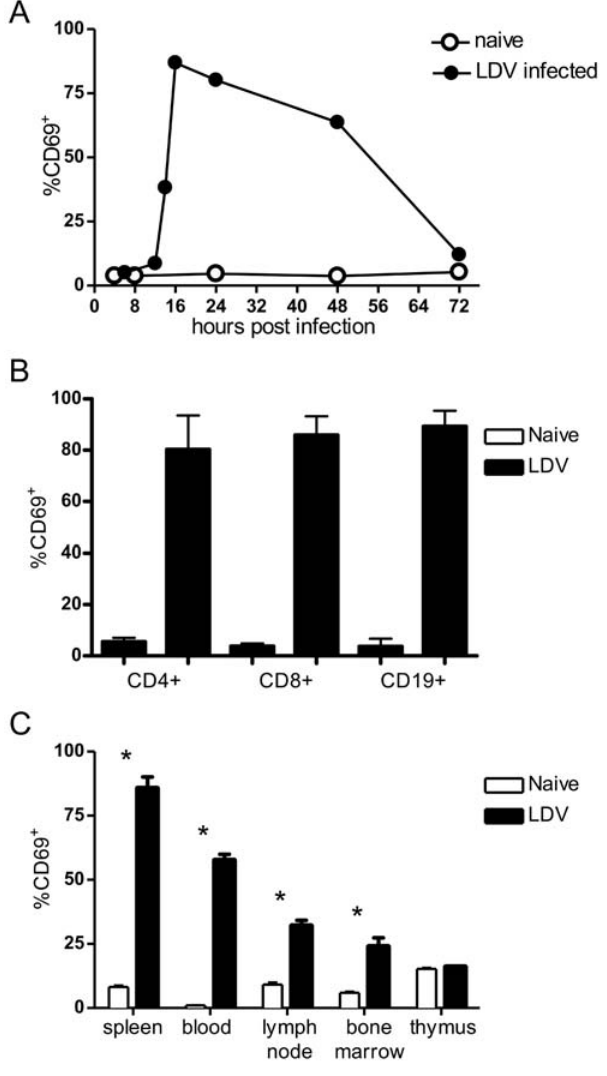
Figure 1. LDV-induced upregulation of CD69. Cells were stained and analyzed by flow cytometry as described (22). (A) Kinetics showing the percentage of splenic lymphocytes with CD69 upregulation. Significant upregulation (P , .05) was observed between 12 and 48hpi (n=2 2 4 mice per group per time point). (B) Upregulation of CD69 on major splenic lymphocyte subsets at 16hpi with LDV was analyzed by co-staining with antibodies for CD69 and either CD4, CD8 or CD19 as indicated. The difference in percentage of CD69 hi cells between naı¨ve and infected mice was statistically significant for all subsets by t test, P=0.0225 for CD4 + T cells, 0.003 for CD8 + T cells, and 0.0018 for CD19 + B cells (n=2 mice per naı¨ve group and 3 mice per infected group.) (C) Tissue distribution of CD69 upregulation. Lymphocytes from spleen, blood, lymph nodes, bone marrow, and thymus were examined at 16hpi with LDV. All tissues except the thymus showed a significantly higher percentage of CD69 hi lymphocytes when infected with LDV infected (P , 0.01 for all groups indicated by *).